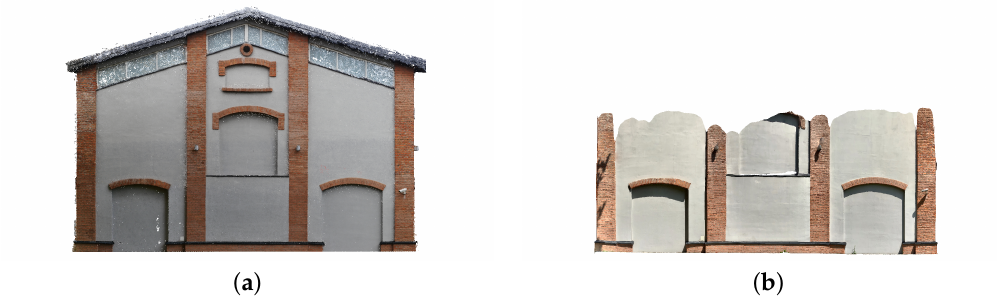
Figure 9. Measurement limits: ( a ) photogrammetry, ( b ) iPad LiDAR.